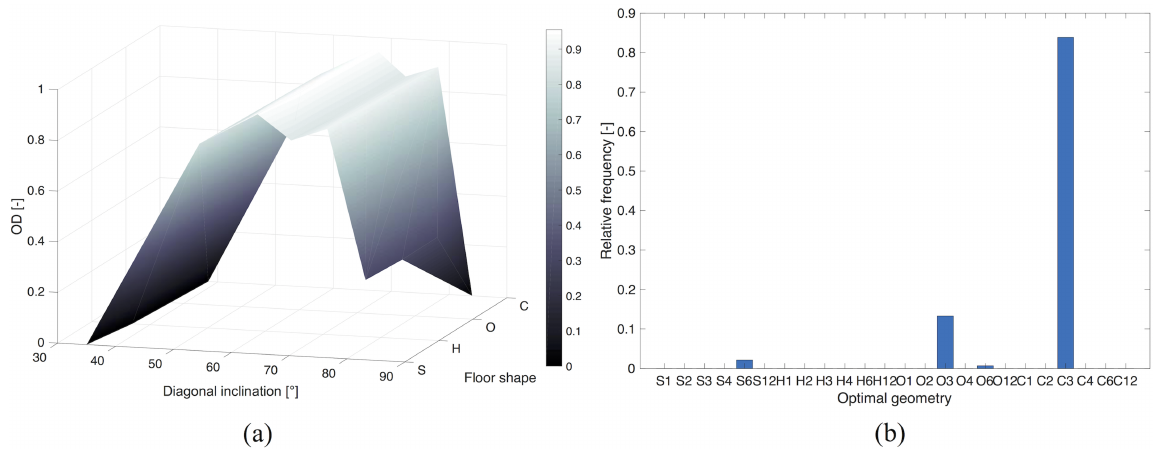
Figure 8: Results for the 252-meter tall building: (a) surface representation of the OD with respect to the diagrid geometrical parameters obtained with r δ = r ϕ = r M = r CI = 1.00 ; (b) optimal diagrid geometry based on 4096 simulations with different exponents r